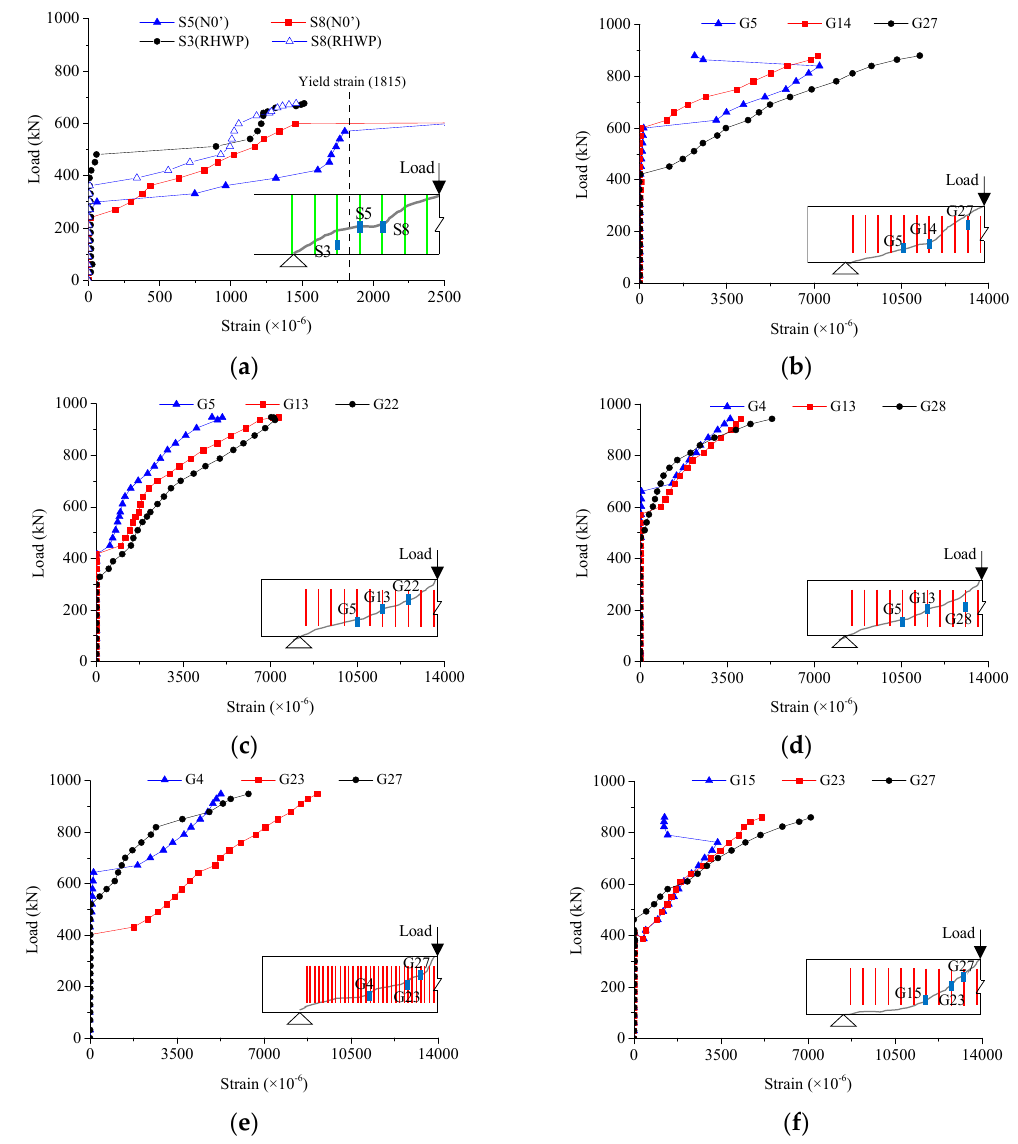
Figure 11. Load–strain ( P– ε ) responses: ( a ) N0 ′ and RHWP; ( b ) RHWC4; ( c ) RHWC6; ( d ) RHWC8; ( e ) RHWC4 ′ ; ( f ) RHWC64. The insert at each panel indicates the location of the strain gauges measured and shown in each plot.